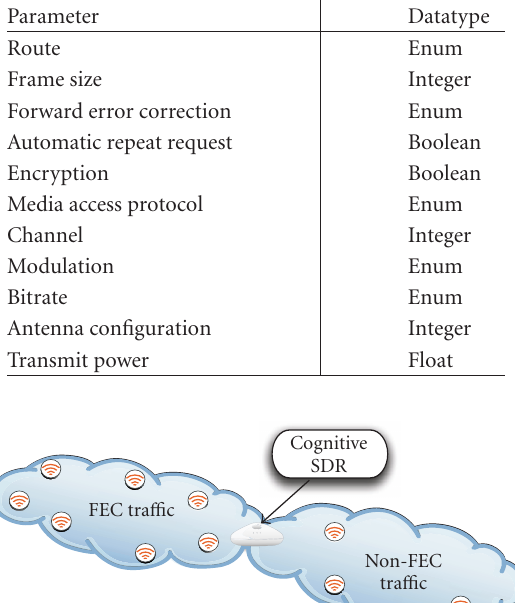
Table 1: A potential set of mutable parameters.